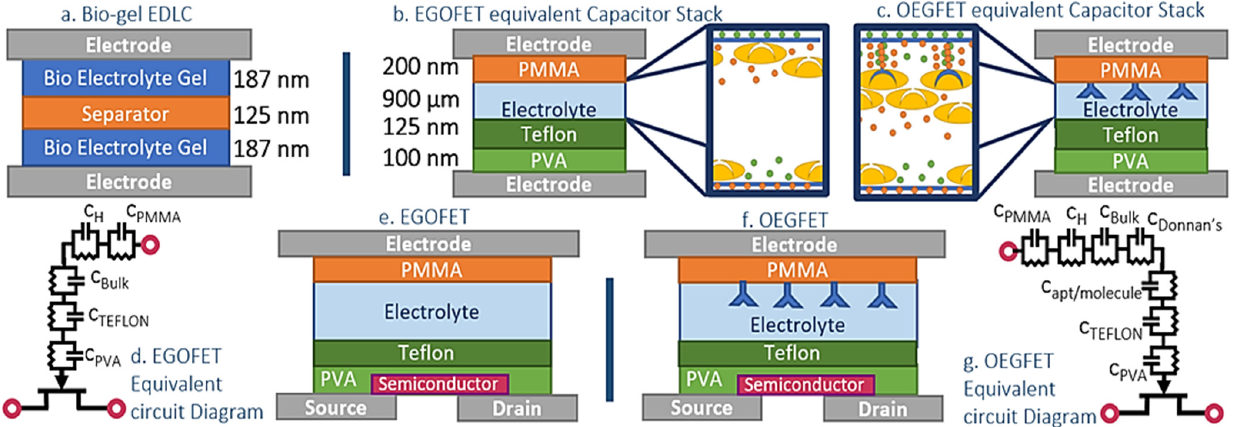
Figure 1. ( a ) Bio-gel EDLC schematic. ( b ) EGOFET equivalent Schematic. ( c ) OEGFET equivalent schematic. ( d ) Equivalent circuit diagram of the EGOFET gate capacitive stack. ( e ) EGOFET device cross section ( f ) OEGFET device cross section ( g ) Equivalent circuit diagram of the OEGFET gate capacitive stack.